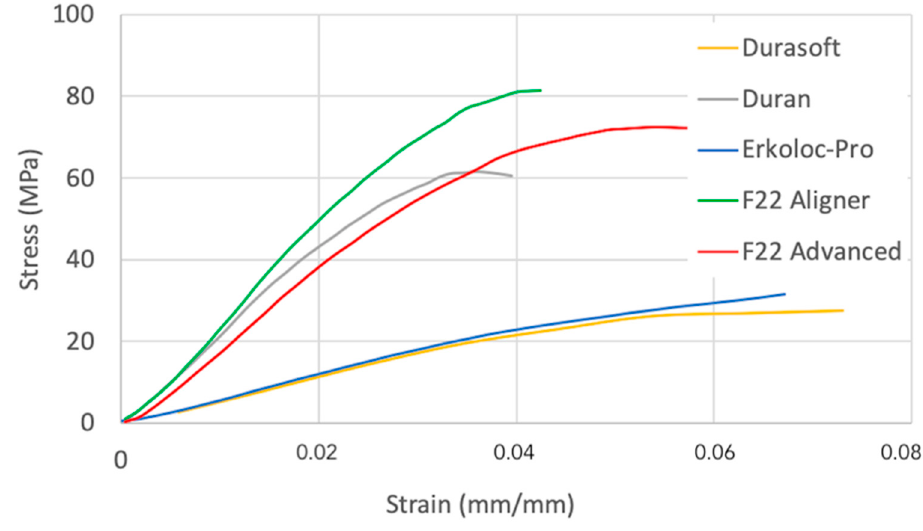
Figure 3. Stress–deformation curve.